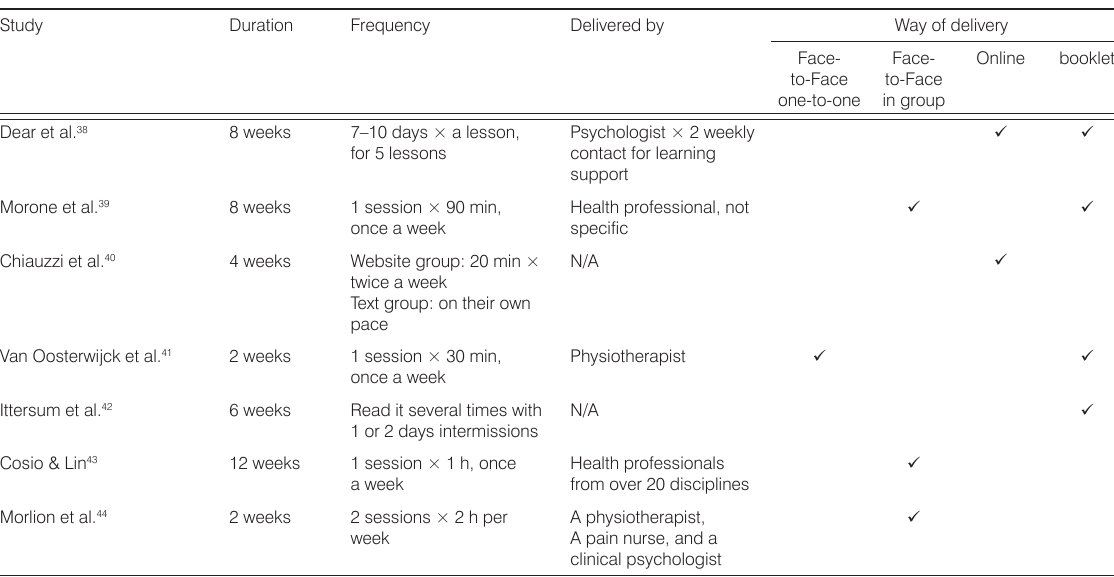
Table 3. Education programs —way of